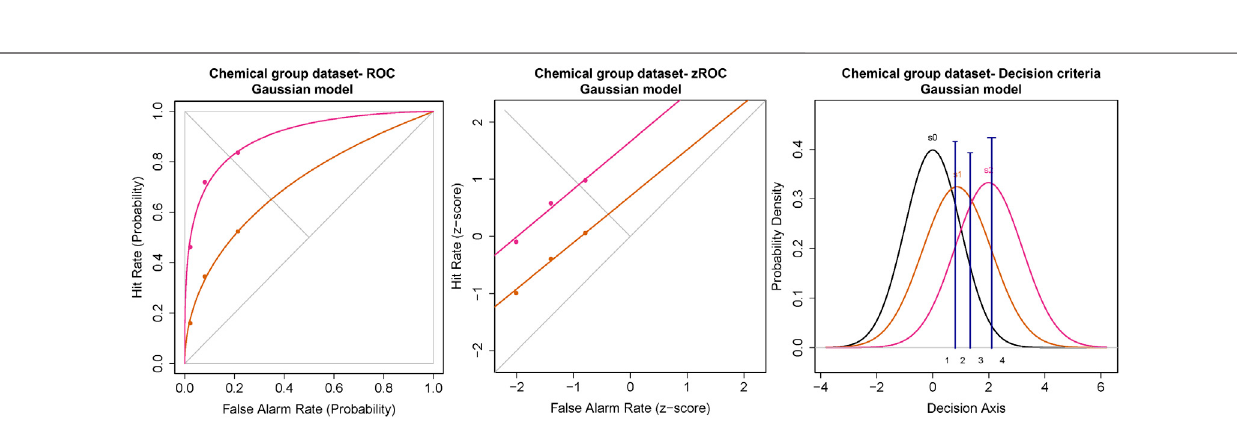
Frontiers in Pharmacology |